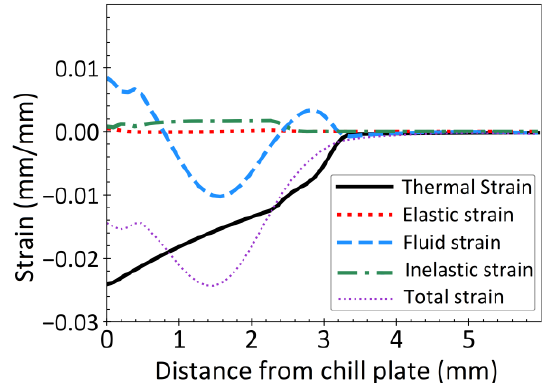
Figure 7. Final radial strain profile through droplet height calculated at centerline symmetry axis with SHF for 0.10%C steel.